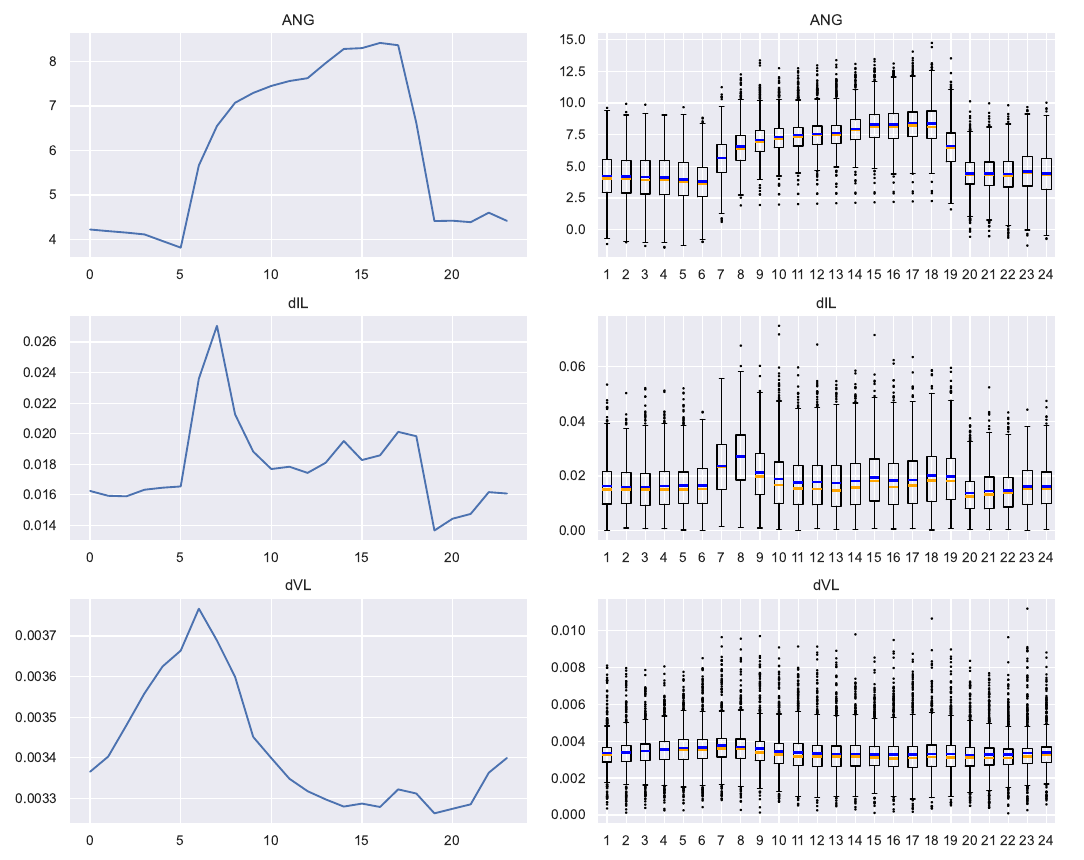
Figure 19. Average profile and box plots of the extended variables in Scenario B. Blue: mean. Orange: median.